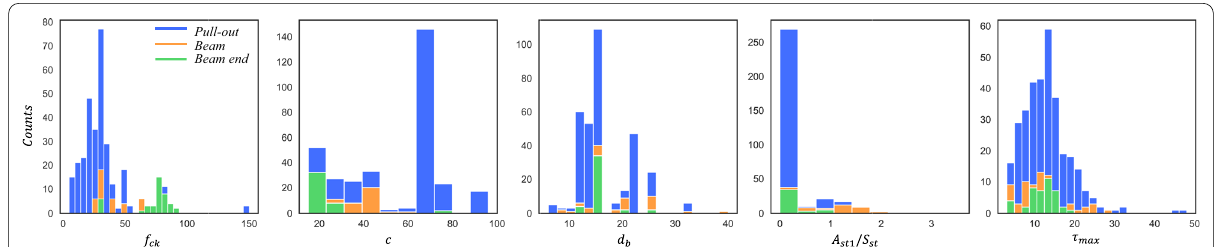
Fig. 4 Histograms of the data sets.